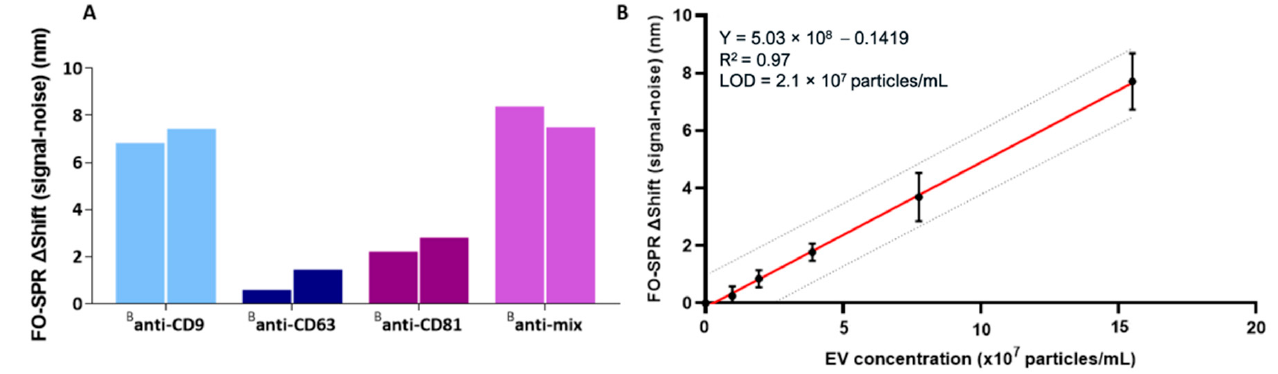
Figure 2. ( A ) FO-SPR sandwich bioassay established with different antibody combinations for detecting SK-BR-3 EVs in buffer. Bar graphs represent the FO-SPR shifts (obtained after subtracting the negative control, i.e., SPR signal for 0 particles/mL) by combining anti-HER2 as capture antibody with different detection antibodies ( B anti-CD9, B anti-CD63, B anti-CD81 or B anti-mix) for detecting SK-BR-3 EVs at 1.55 × 10 8 particles/mL concentration (measurements shown from two independent experiments). ( B ) FO-SPR-based detection of a series of SK-BR-3 EV concentrations spiked in the detection buffer (50 mM MES pH 6, 0.01% BSA, 0.01% Tween 20) when using the anti-HER2/ B anti-CD9 antibody combination (obtained after subtracting the negative control, i.e., SPR signal for 0 particles/mL). Simple linear regression fitting was performed by GraphPad Prism software (Version 8.0.1, GraphPad Software Inc., MA, USA). The dotted lines indicate the 95% prediction bands for a new observation. Error bars represent one standard deviation ( n = 3).